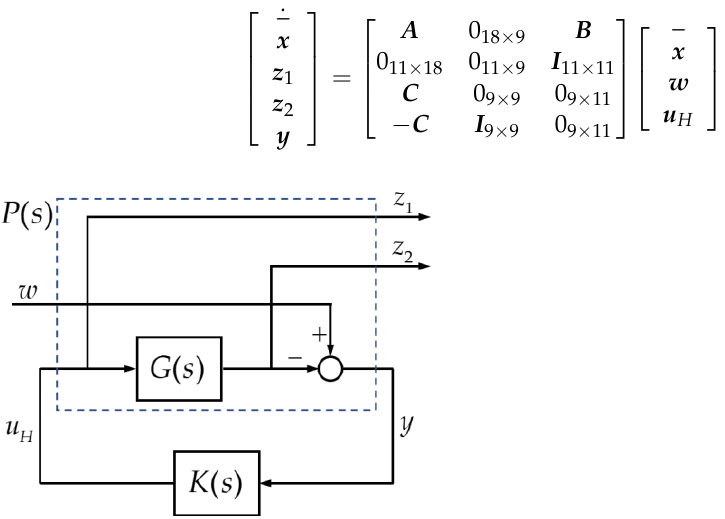
Figure 4. A schematic drawing of the mixed sensitivity H ∞ control framework.